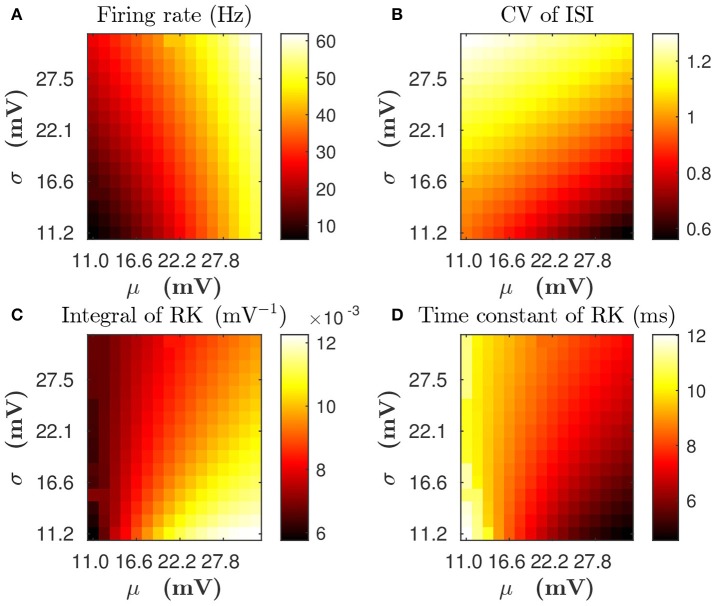
The dependence of statistical properties of the LIF neuron on the mean μ and the standard deviation σ of external inputs. (A,B) Firing rate and CV of inter-spike interval (ISI), respectively. (C,D) Integral of response kernel ∫h(τ)dτ and linear response time constant τeff, respectively.